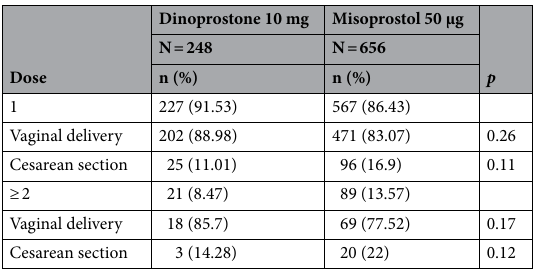
Table 6. Dose of dinoprostone and misoprostol and mode of delivery.